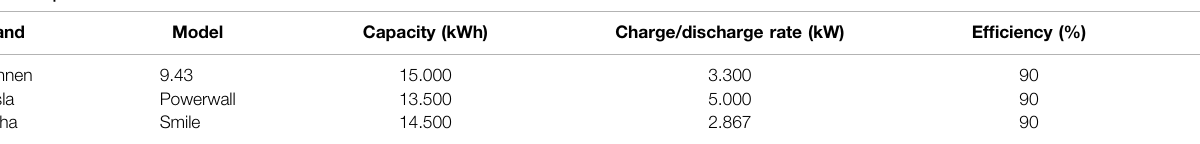
TABLE 1 | Prosumers batteries characteristics.